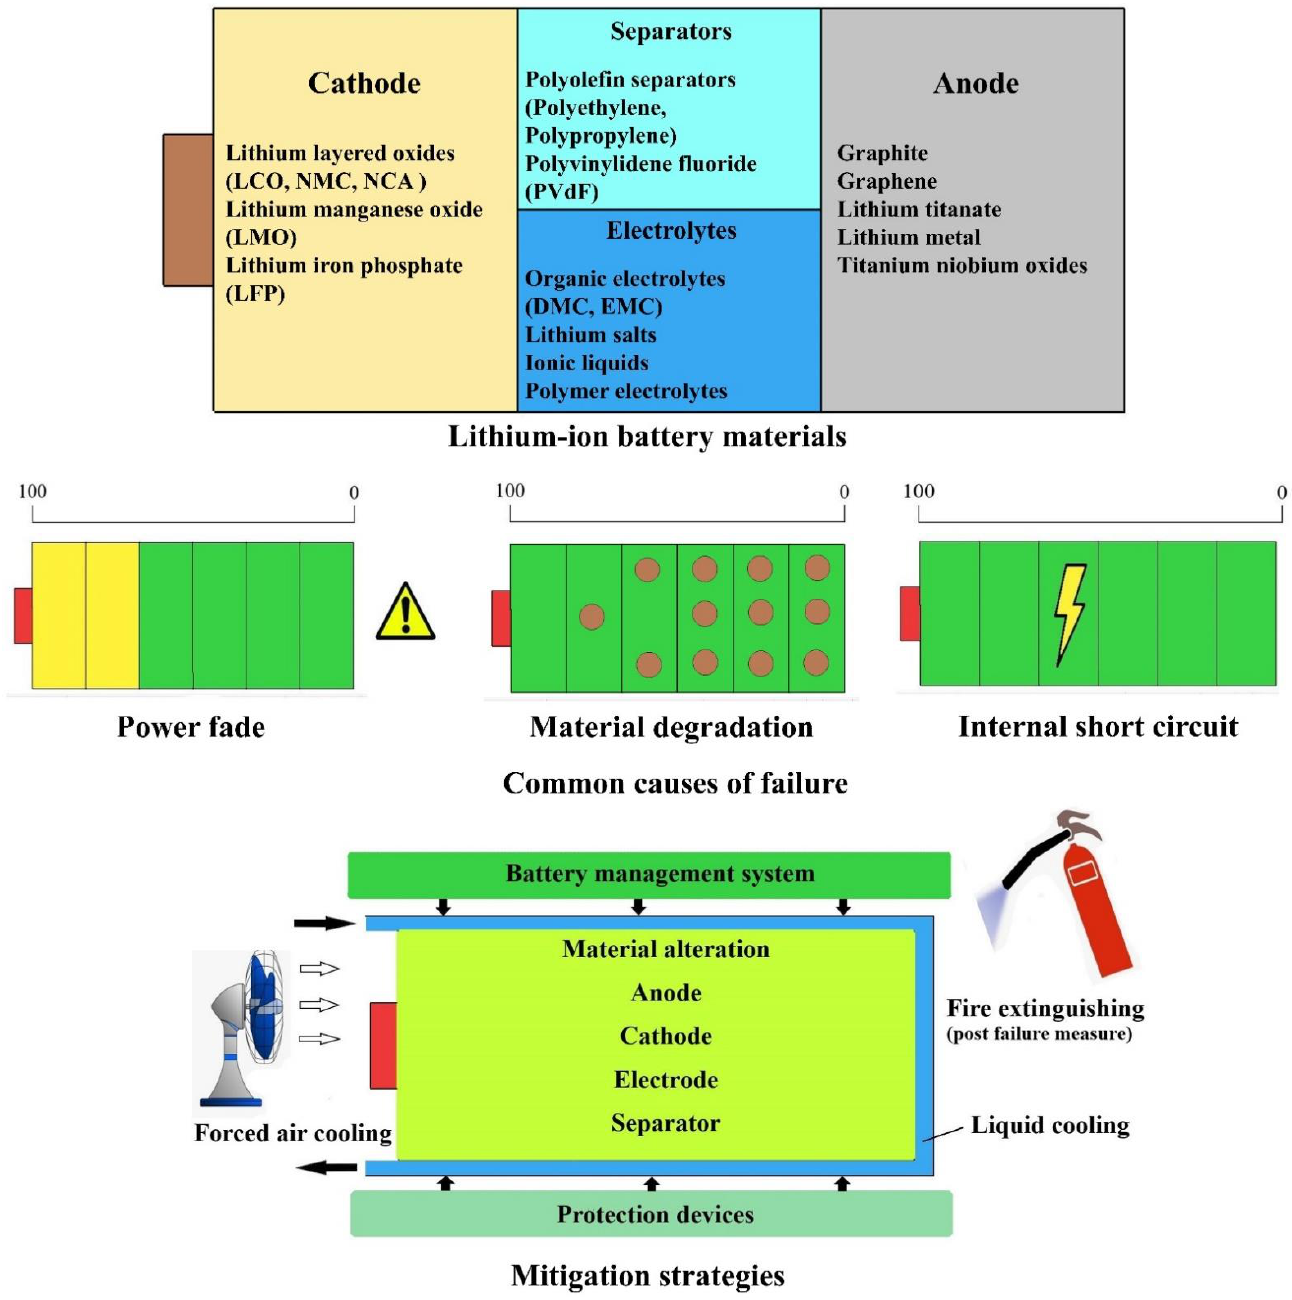
Figure 1. LiBs materials, causes of failure, and mitigation strategies.